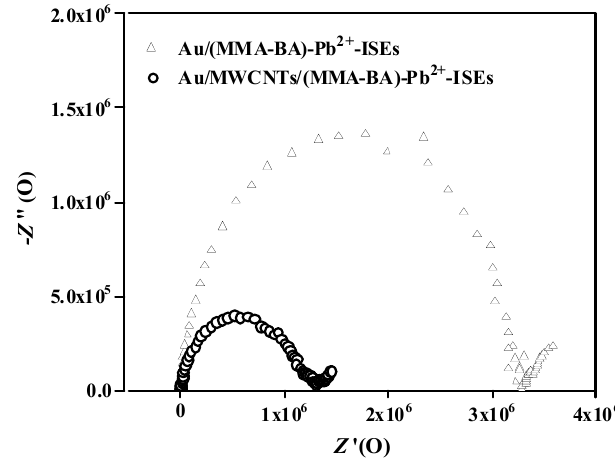
Z '(O) Figure 6. Impedance spectra of Au / (MMA-BA)-Pb 2 + -ISEs (triangle) and Figure 6. Impedance spectra of Au/(MMA ‐ BA) ‐ Pb 2+ ‐ ISEs (triangle) and Au / MWCNTs / (MMA-BA)-Pb 2 + -ISEs (circle) in 1.5 × 10 − 3 mol · L − 1 Pb 2 + solution. E dc , 0.2 V; Au/MWCNTs/(MMA ‐ BA) ‐ Pb 2+ ‐ ISEs (circle) in 1.5 × 10 − 3 mol ∙ L − 1 Pb 2+ solution. E dc , 0.2 V; excitation excitation amplitude, 100 mV; frequency range, 0.01 Hz − 100 kHz. amplitude, 100 mV; frequency range, 0.01 Hz − 100 kHz.